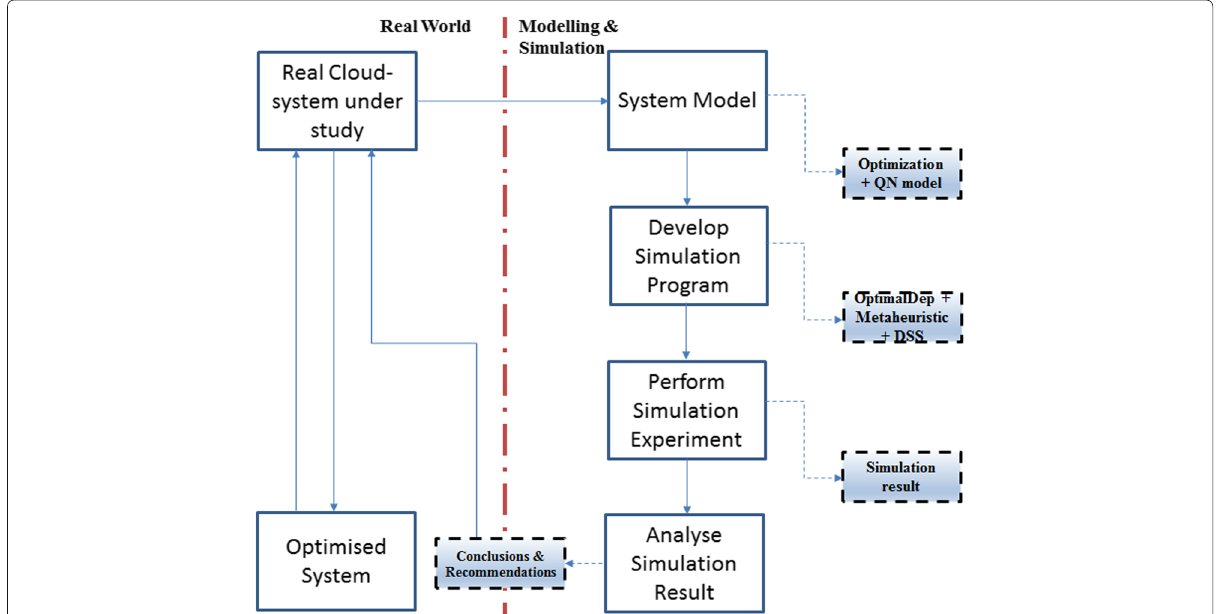
Fig. 2 Modelling and Simulation technique used for the